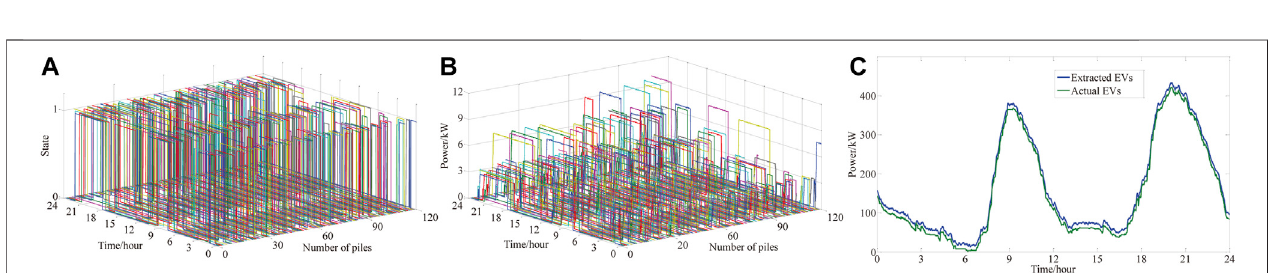
FIGURE 9 | Charging load decomposition effect of the traditional FHMM. (A) Charging state of 120 charging piles. (B) Charging power of charging piles. (C) Total charging power of EVs decomposed based on the FHMM.